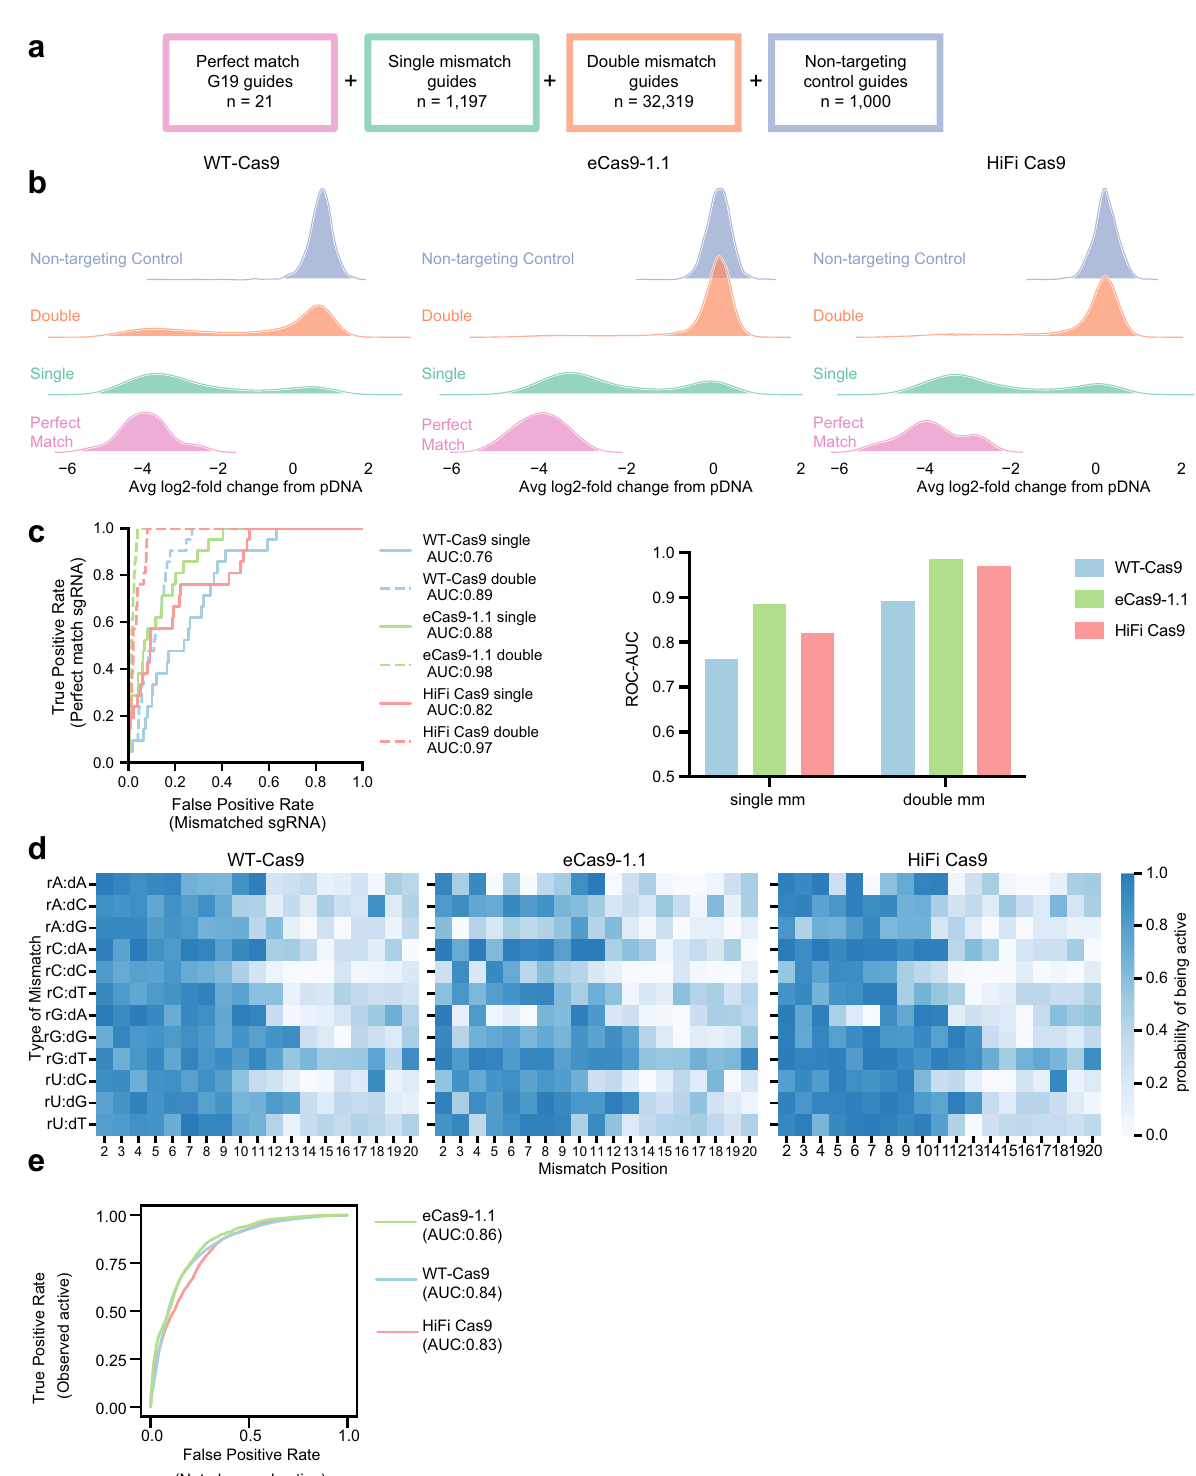
Fig. 2 Off-target pro fi les of high- fi delity variants. a Schematic depicting off-target library construction and guide selection. b Ridge plots showing activity of guides in the library with zero, one or two mismatches. c ROC plots for each enzyme screened with single (solid lines) and double mismatched sgRNAs (dashed lines). AUC is reported in the graph legend. Data are also summarized in a barplot. d CFD matrices for each enzyme, numbered such that 2 is the second nucleotide in the guide. Note that mismatches start at position 2, because the fi rst position of the guide is always fi xed as a G. e ROC plot depicting ability to predict activity at double mismatches using single mismatch data. True positives are guides that were observed to be active, false positives are guides that were not active in the screen. Source data are provided as a Source Data fi